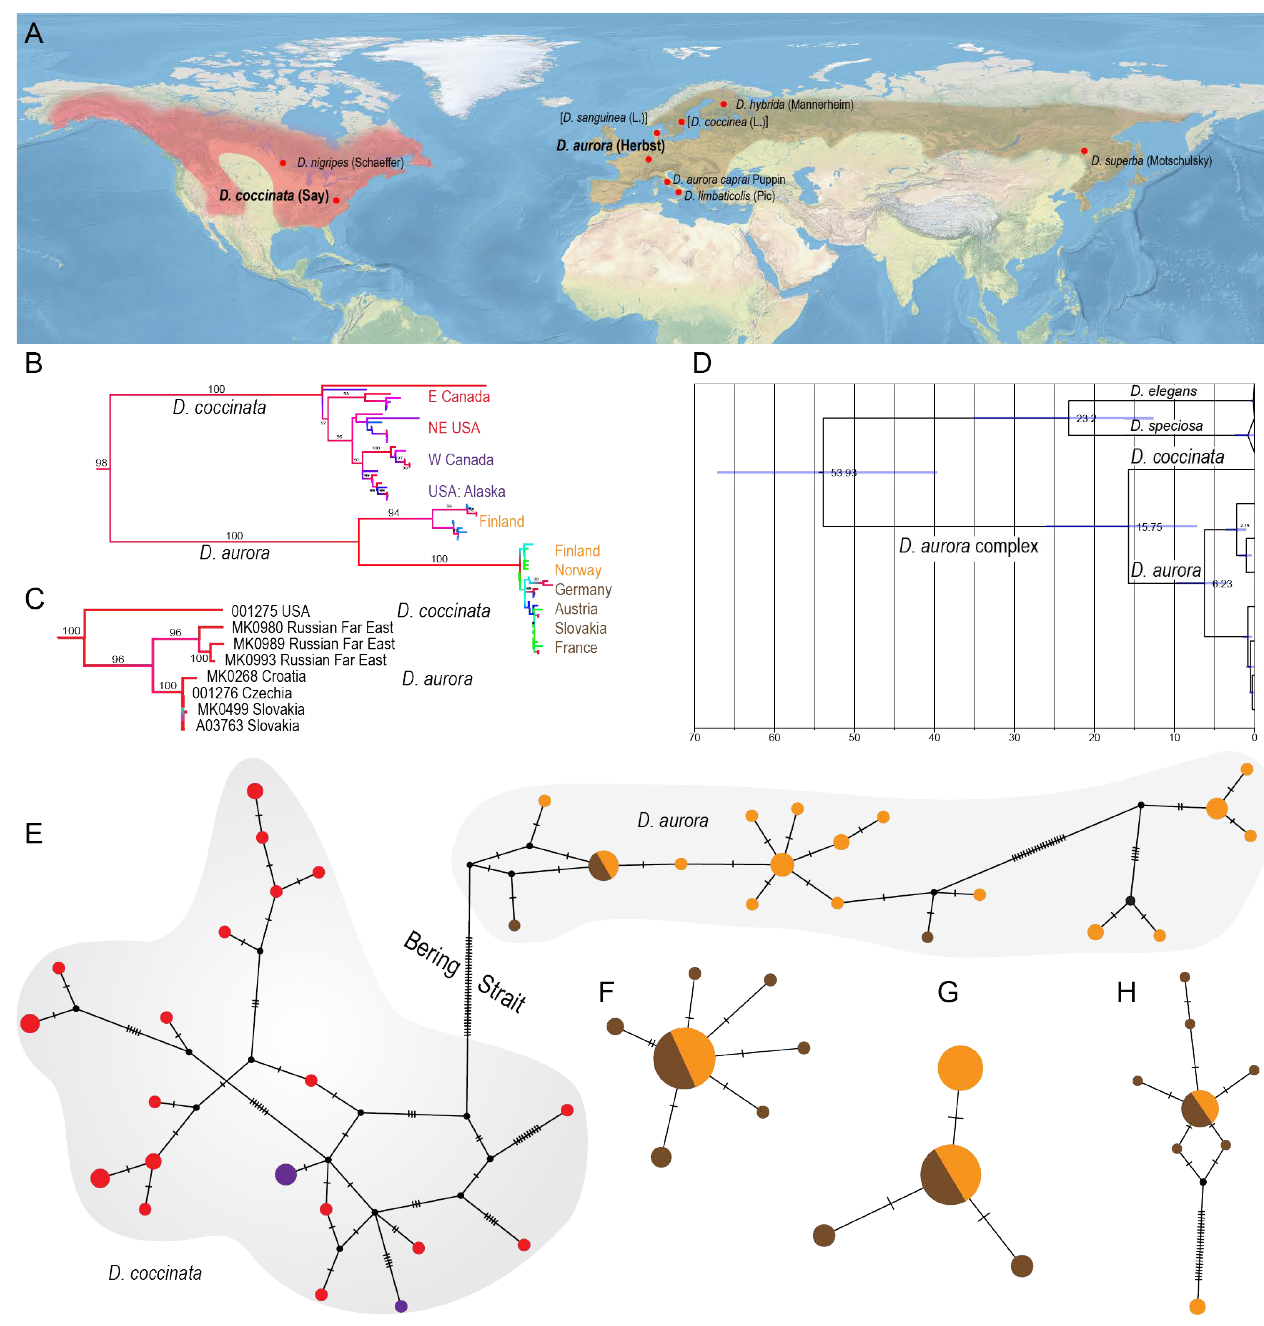
Figure 1. ( A ) Distribution of Dictyoptera aurora (Herbst) and D. coccinata (Say); the red dots designate type localities of individual taxa proposed in the D. aurora complex; valid names are given in bold, available names (younger synonyms) in regular font and unavailable names (junior primary homonyms) in square brackets. ( B ) The cox1-5 (cid:48) mtDNA tree as recovered by the IQ-tree maximum likelihood (ML) analysis. The node labels show bootstrap fractions. Shallow relationships are not statistically supported, and bootstrap fractions are omitted. ( C ) ML tree of the Dictyoptera aurora complex inferred from rRNA and mtDNA markers within the analysis of the whole family. ( D ) Dated tree of three species of Dictyoptera , the part of the whole-family tree displayed. ( E – G ) Haplotype networks constructed from barcodes: ( E ) D. coccinata and D. aurora ; ( F ) Lygistopterus sanguineus (L.); ( G ) Platycis minuta (Thomson); ( H ) Pyropterus nigroruber (De Geer). Pie colors designate the following regions (corresponding to label colors in ( B )): red—Eastern USA and Canada; violet—Alaska and Western Canada; orange—Fennoscandia; brown—the rest of Europe; black pies designate hypothetical